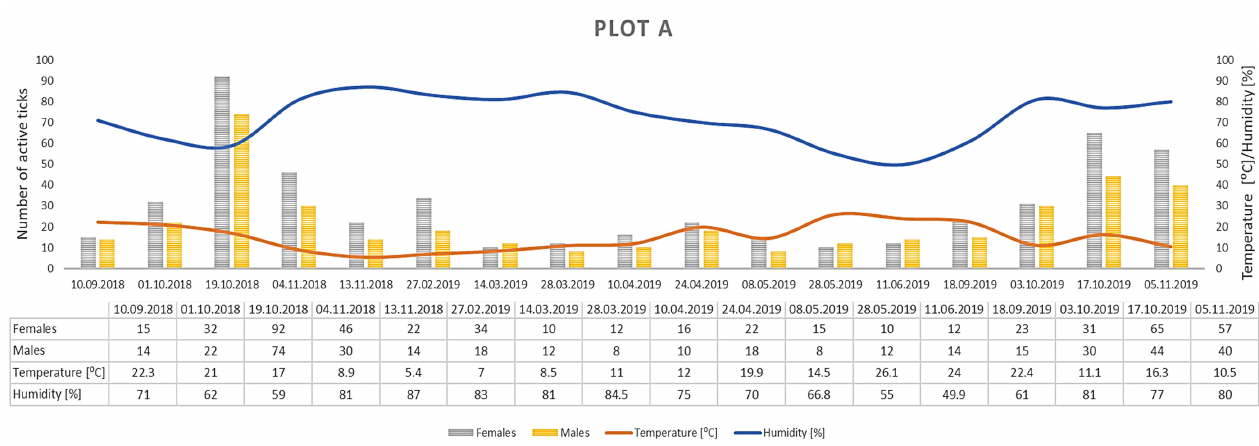
Figure 3. Abundance and seasonal activity of Dermacentor reticulatus adults in research plot A and weather conditions prevailing during tick collection. Predominance of active ticks in autumn.